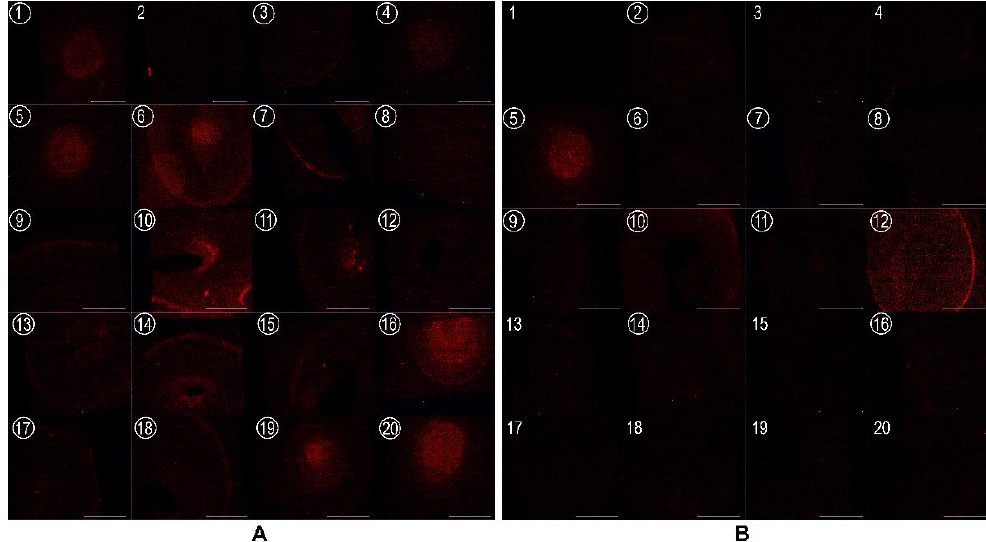
Figure 7. Dot blot images of EryA-mCherry binding to total lipid extracts from clinical supragingival plaque samples from patients and healthy individuals. Twenty samples ( A ) from patients with periodontal disease and twenty ( B ) from healthy individuals (200 µg lipids) were applied on a nitrocellulose membrane, incubated with EryA-mCherry (2 µg/mL) and the intensity of fluorescence was measured. Scale bar: 5 mm. Positive samples are indicated by a number within the circle.